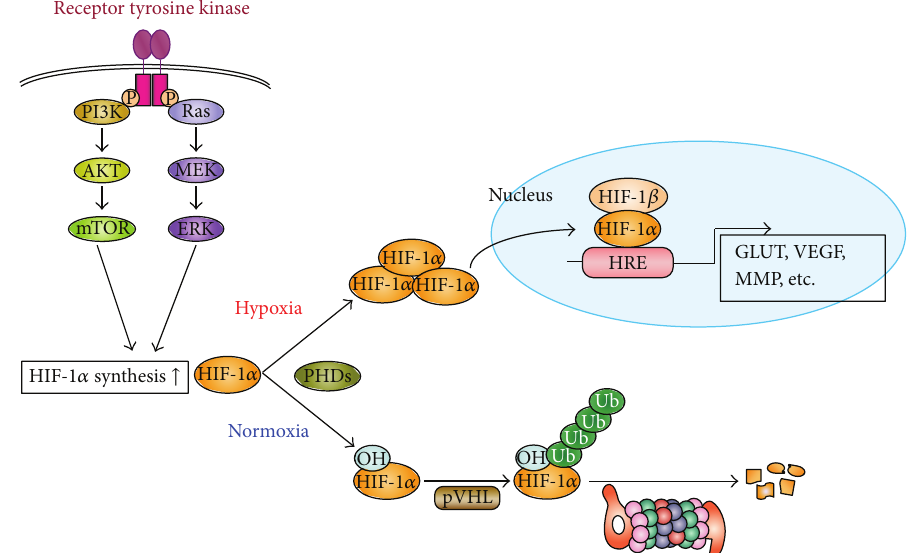
Figure 1: Regulatory mechanism of hypoxia-inducible factor (HIF-1) expression. Growth factor stimulation induces HIF-1 𝛼 subunit (HIF-1 𝛼 ) protein synthesis by activating PI3K/Akt/mTOR and Ras/MEK/ERK kinase pathways. Under normoxic conditions, HIF-1 𝛼 is hydroxylated by proline hydroxylases (PHDs), triggering its interaction between von Hippel-Lindau tumor suppressor protein (pVHL), leading to its polyubiquitination and subsequent proteasomal degradation. In contrast, under hypoxic conditions, HIF-1 𝛼 remains stable, enters the nucleus, and, together with HIF-1 𝛽 , binds to hypoxia-responsive elements (HREs), upregulating the expression of target genes such as glucose transporters (GLUTs), vascular endothelial growth factors (VEGFs), and matrix metalloproteinases (MMPs). Ub: